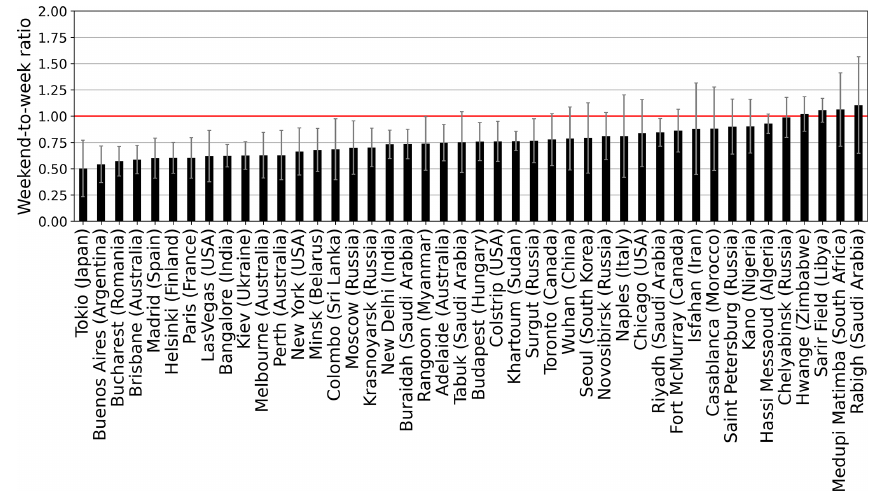
Figure 7. Weekend-to-weekday ratio of NO x emission data (1 March 2018 to 29 February 2020) from left to right in increasing ratio. Data are separated into working and weekend days for 44 source regions. Weekend can be one or two days, and those days can also differ according to religious tradition, which is considered. The red line indicates the 1 : 1 line where weekend and week NO x emissions are equal; below the line emissions during the week are predominant, and above the line weekend emissions are higher. Error bars are the standard deviation derived by the EMG fitting procedure for emission